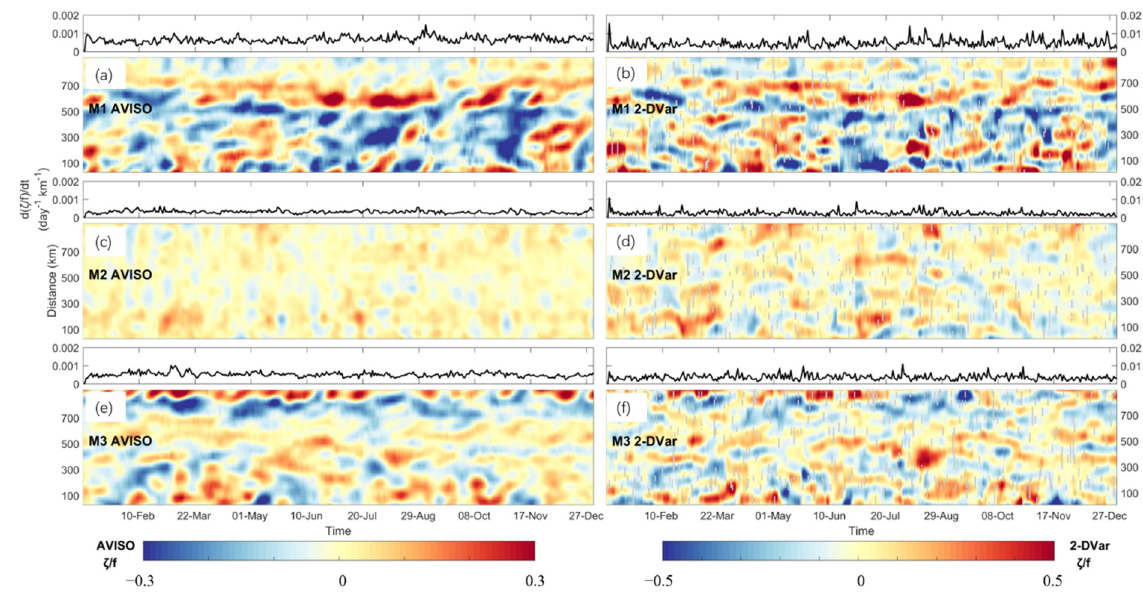
Figure 3. Time evolution of AVISO geostrophic vorticity along ( a ) Line 1, ( c ) Line 2 and ( e ) Line 3 and time evolution of 2-DVar geostrophic vorticity along ( b ) Line 1, ( d ) Line 2 and ( f ) Line 3. The shaded color represents the normalized geostrophic vorticity divided by the local geostrophic parameter. The y -axis is the distance from the sampling line’s southernmost grid point. The gray dots in the 2-DVar figures indicate that there is at least one satellite altimeter observation data. The line graph represents the change rate of normalized vorticity.